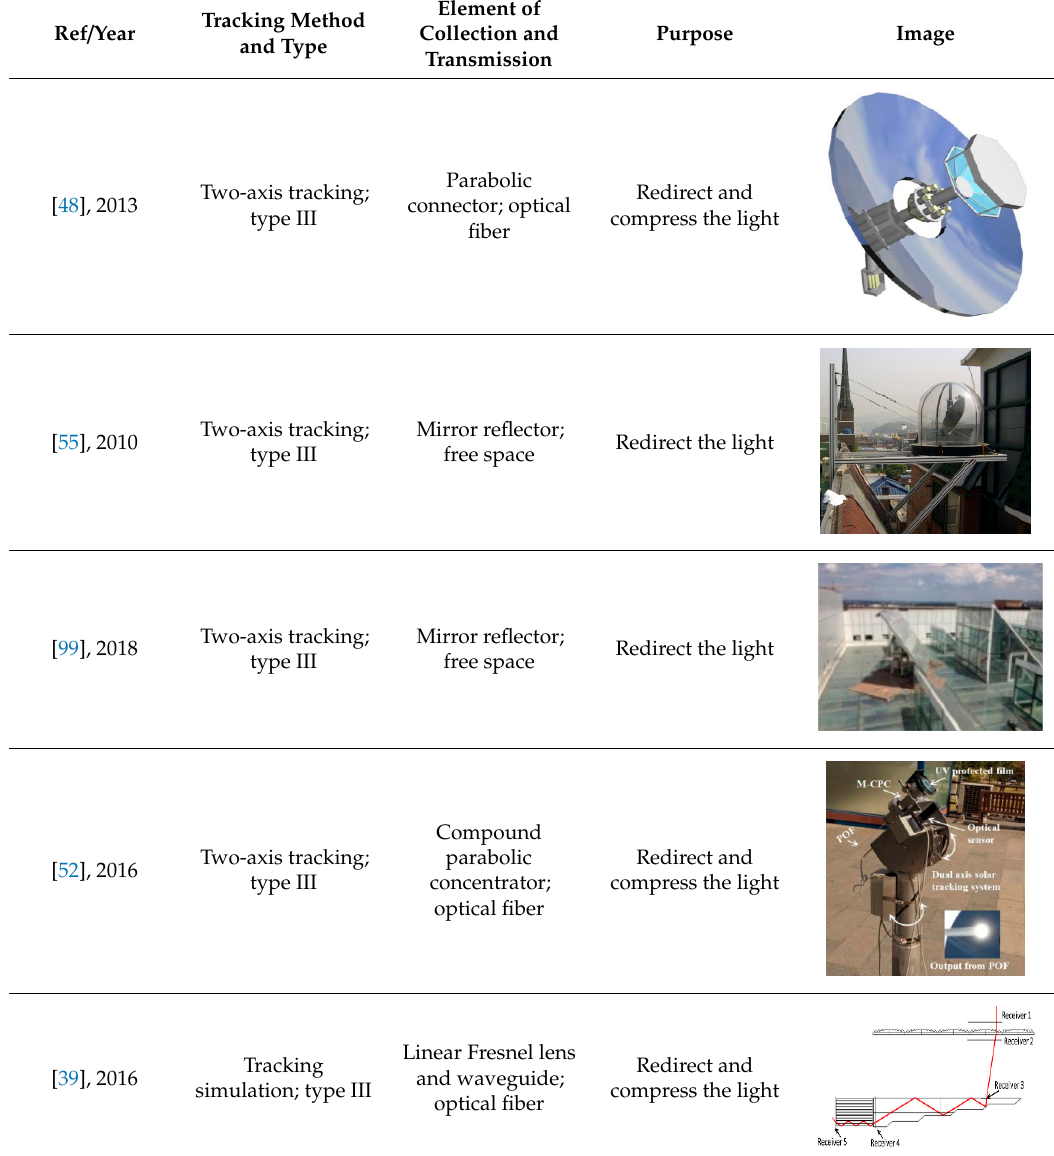
Table 5. Element of the active prototype daylighting system.